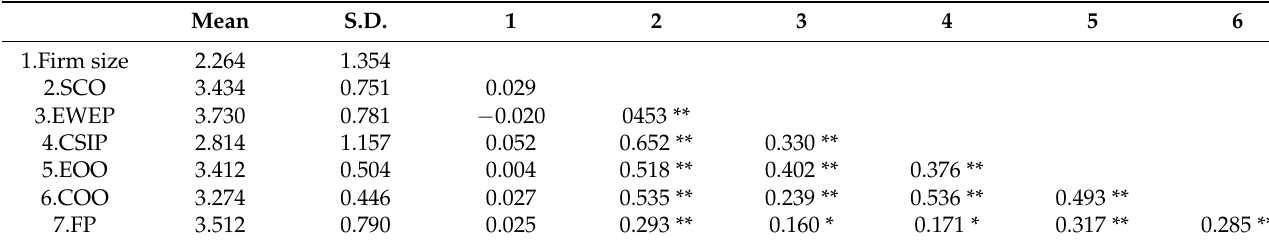
Table 2. Inter-construct correlations and